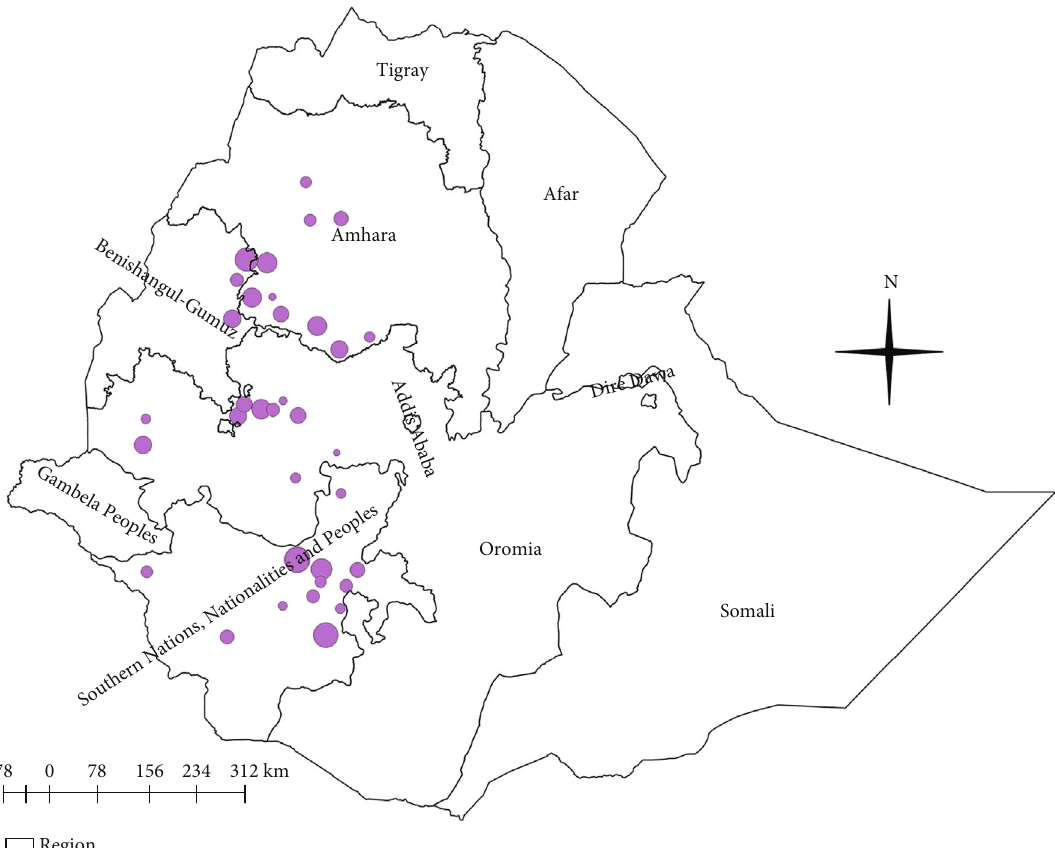
Figure 1: The spatial distribution of cattle trypanosomosis in di ff erent regions of Ethiopia